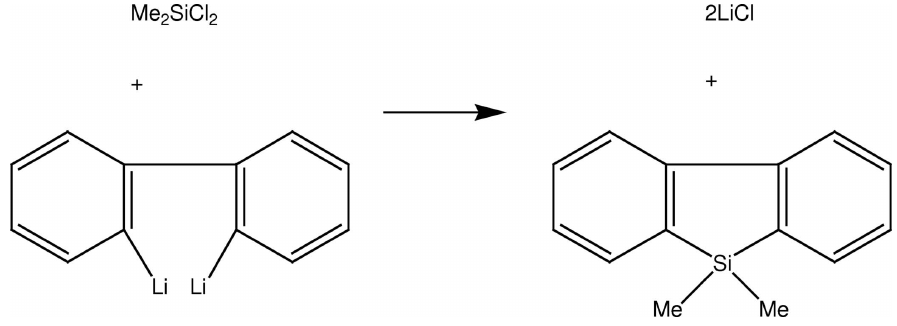
Perspective view of the second molecule in the asymmetric unit of the title compound with the atom numbering scheme; displacement ellipsoids are at the 50% probability level; H atoms are drawn as small spheres of arbitrary radii.